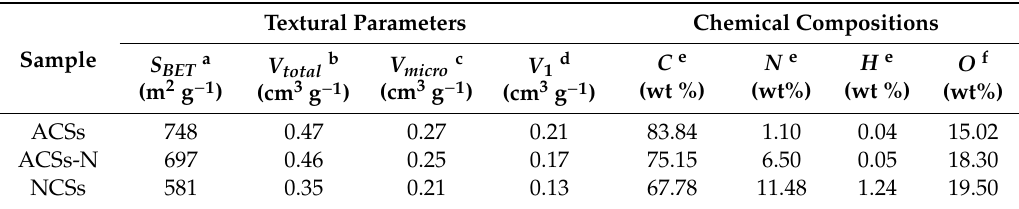
Figure 4. ( a ) N 2 adsorption − desorption isotherms and ( b ) pore size distribution (PSD) curves of the porous carbons NCSs, ACSs, and ACSs-N. Table 1. Textural parameters and chemical compositions of the porous carbons.